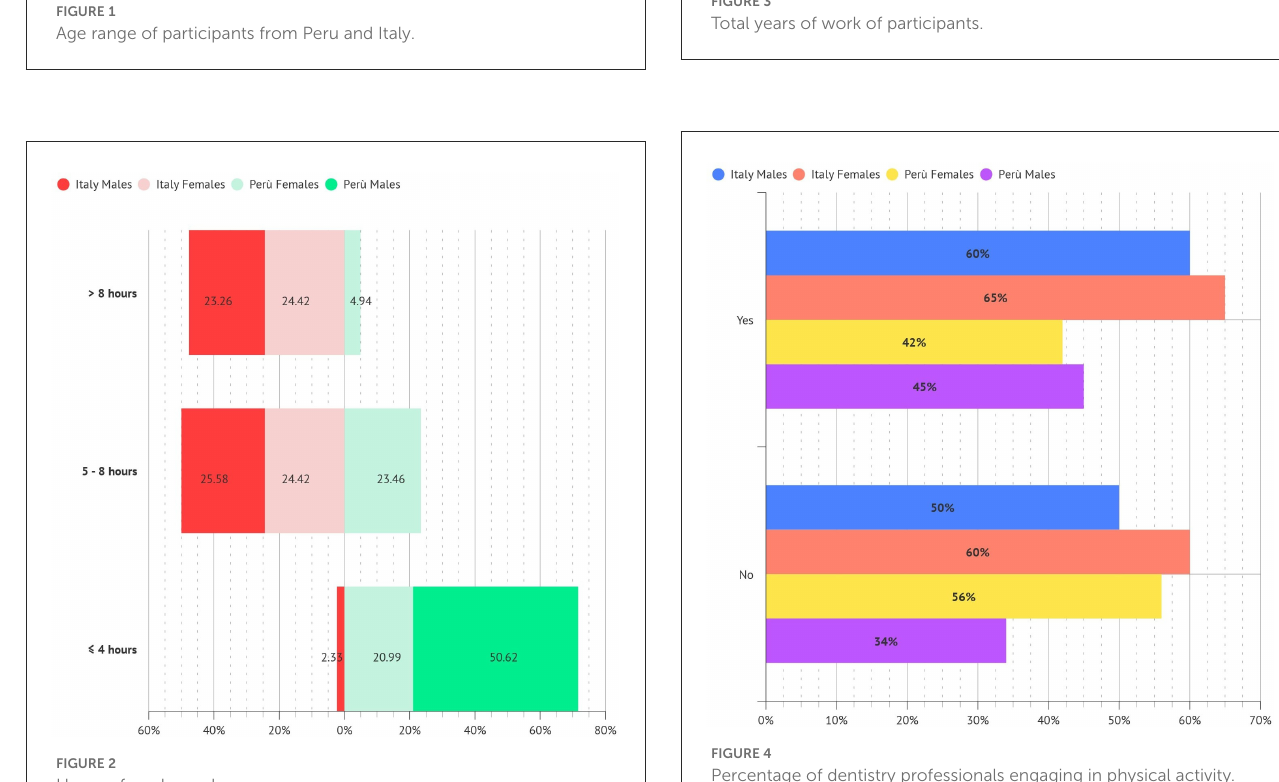
FIGURE3 Total years of work of participants.